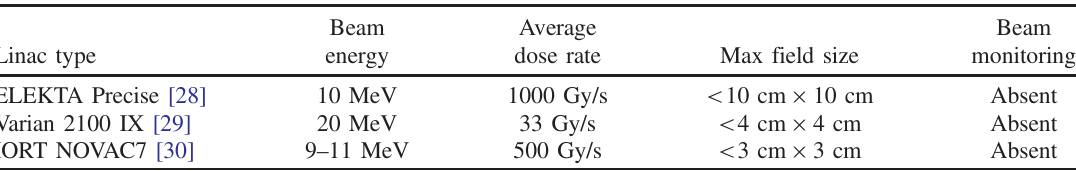
TABLE I. Table of modified existing